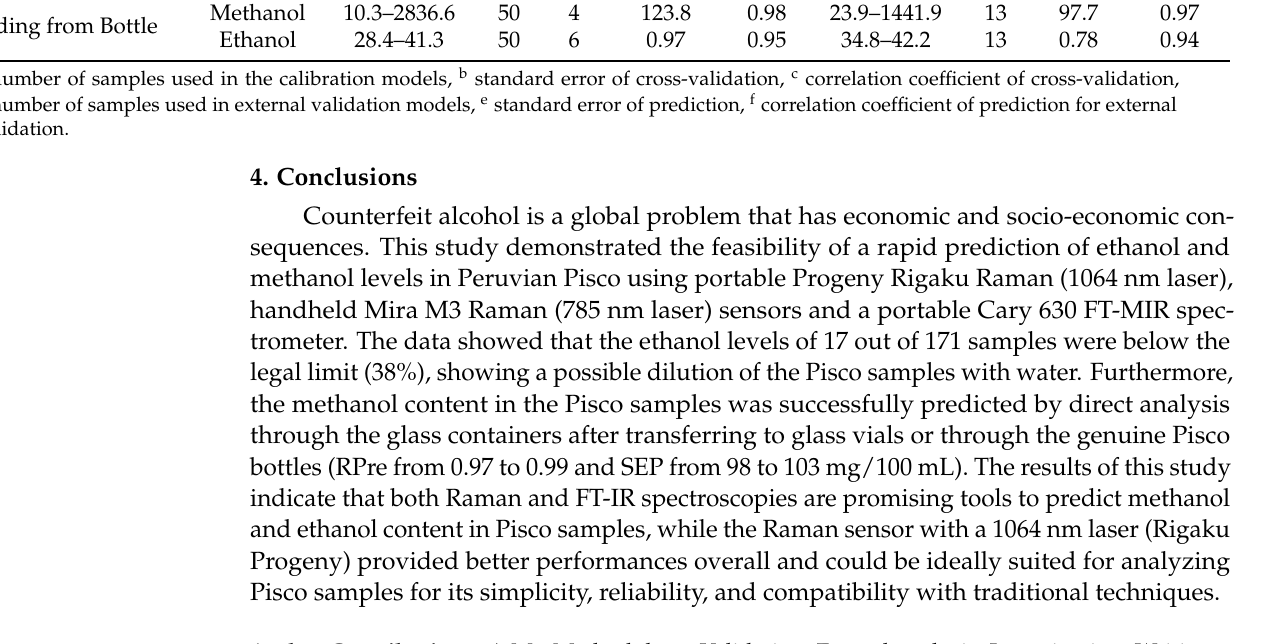
Table 2. Performance of calibration and validation models developed by using a handheld Progeny Rigaku (1064 nm) Raman instrument for the determination of ethanol and methanol levels in spiked and pure Peruvian Pisco samples through their genuine bottles and glass vials.